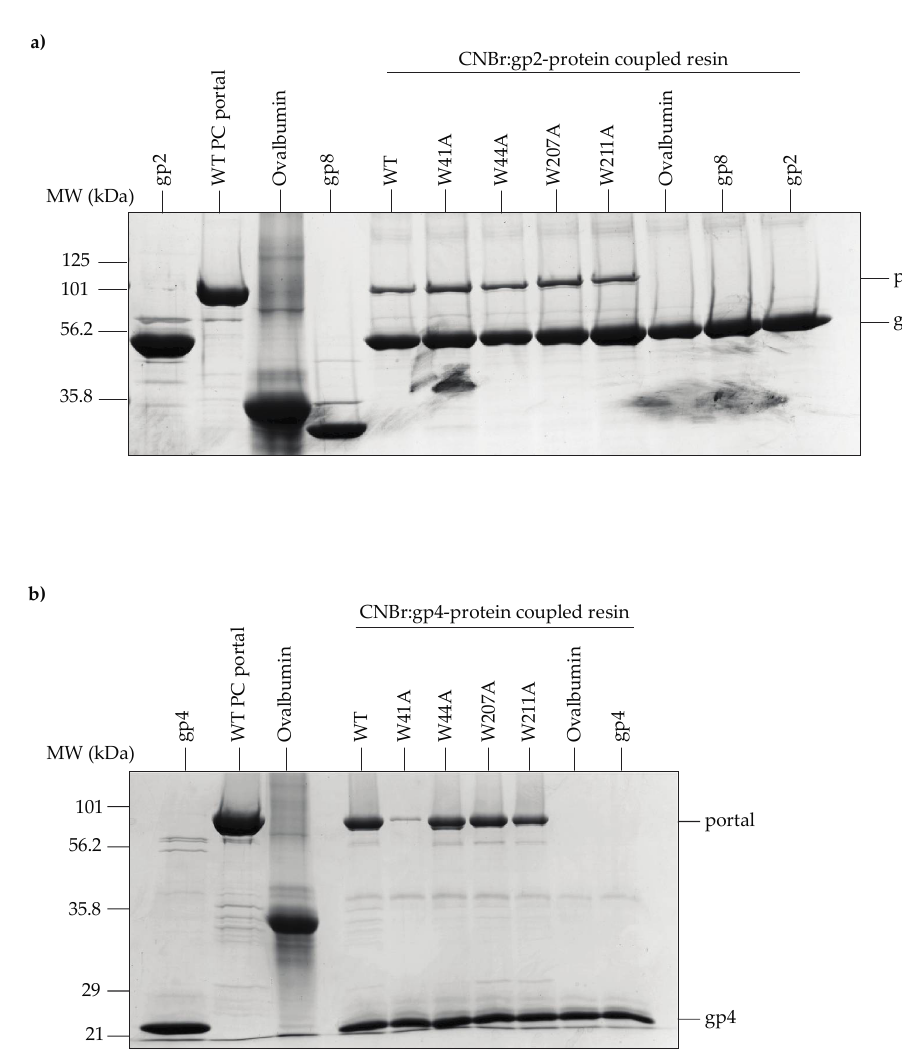
Figure 7. WT and mutant PC portal rings interact with large terminase (L-terminase; gp2) and gp4 immobilized on CNBr-activated Sepharose 4B. ( a ) SDS-PAGE analysis of PC portal rings binding to gp2-Sepharose; ( b ) SDS-PAGE analysis of PC portal rings binding to gp4-Sepharose. Ovalbumin and gp8 (P22 scaffolding protein) are negative controls.